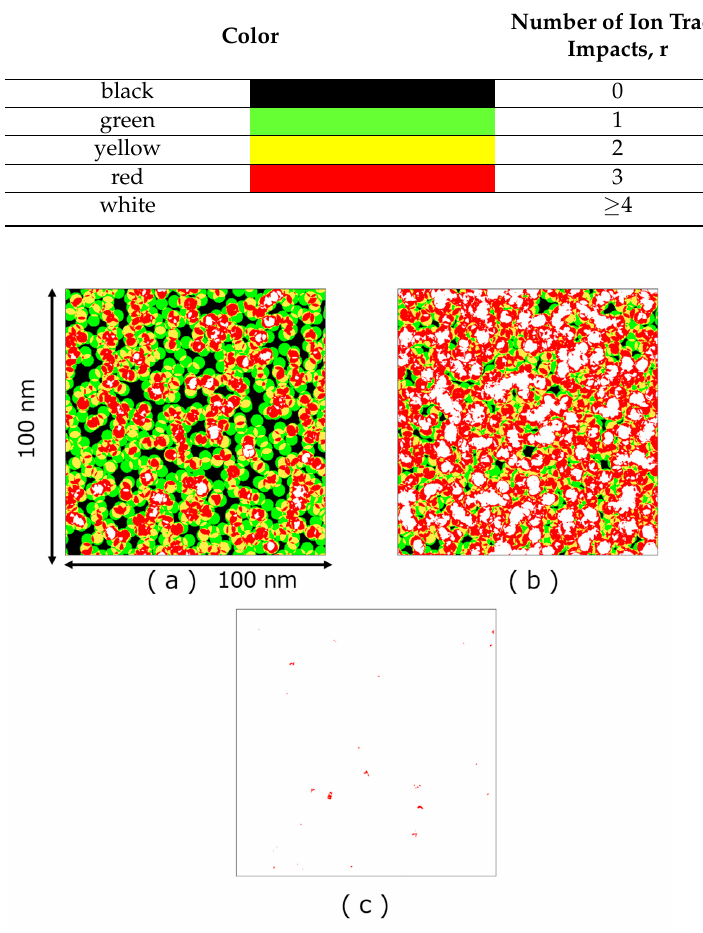
Figure 7. Two-dimensional images of irradiation-induced magnetization for ion fluences of ( a ) 5 × 10 12 cm 2 , ( b ) 1.5 × 10 13 cm 2 and ( c ) 3 × 10 13 cm 2 . The diameter of ion track is assumed to be 4.7 nm. The correspondence relationship for colors and the values of magnetization is shown in Table 1.